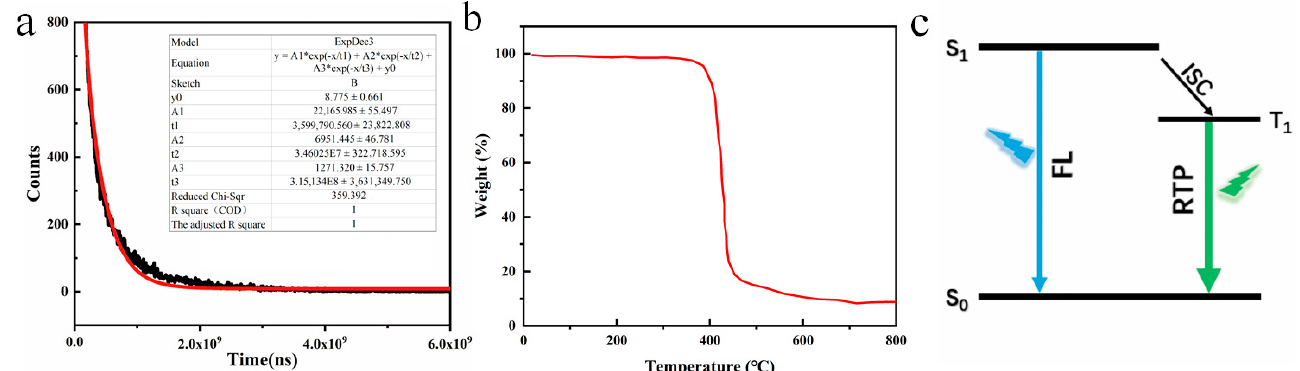
Figure 4. Phosphorescence decay curves for long afterglow materials ( a ), thermo-gravimetric anal- ysis (TGA) curves ( b ), and a schematic of the room temperature phosphorescence (RTP) emission mechanism (the absorption process is omitted and the width of the emission line is used to roughly represent the intensity of fl uorescence or room temperature phosphorescence emission) ( c ).